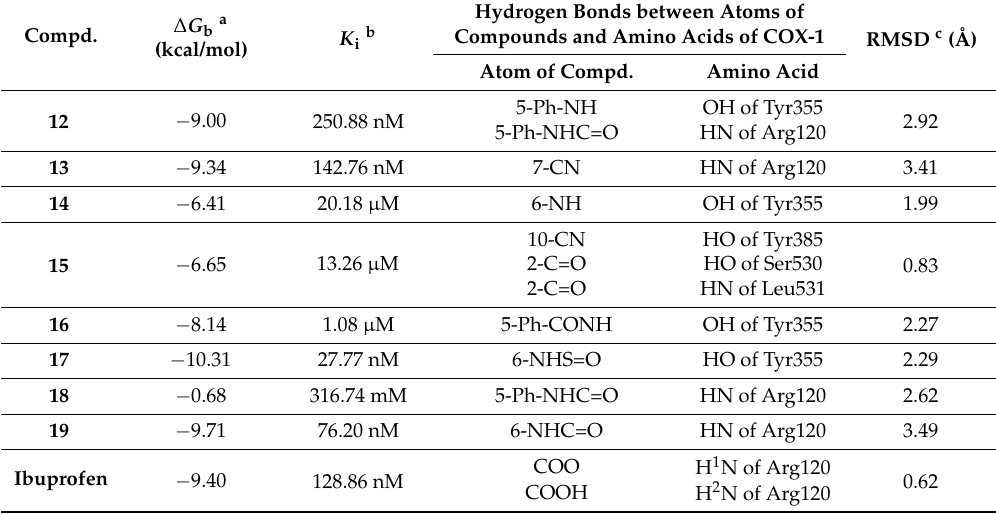
Table 3. Results of the flexible docking of compounds 12 – 19 into ovine COX-1 (pdb: 1eqg) [34] in comparison to the native co-crystallized ibuprofen.